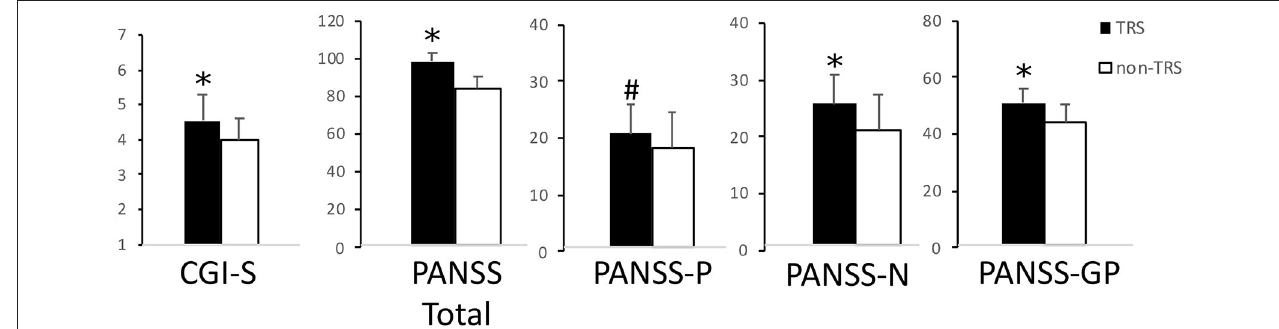
FIGURE 1 | Disease severity and psychotic symptoms. In this picture are reported TRS and non-TRS groups’ mean scores + standard deviations on the (from left to right): Clinical Global Impression-Severity (CGI-S) scale; Positive and Negative Syndrome Scale (PANSS) Total score; PANSS Positive Symptoms’ Subscale (PANSS-P); PANSS Negative Symptoms’ Subscale (PANSS-N); PANSS General Psychopathology Subscale (PANSS-GP). Note the different scales on multiple graphics. * p < 0.05 at the Student’s t -test. # Trend toward significance ( p = 0.06).